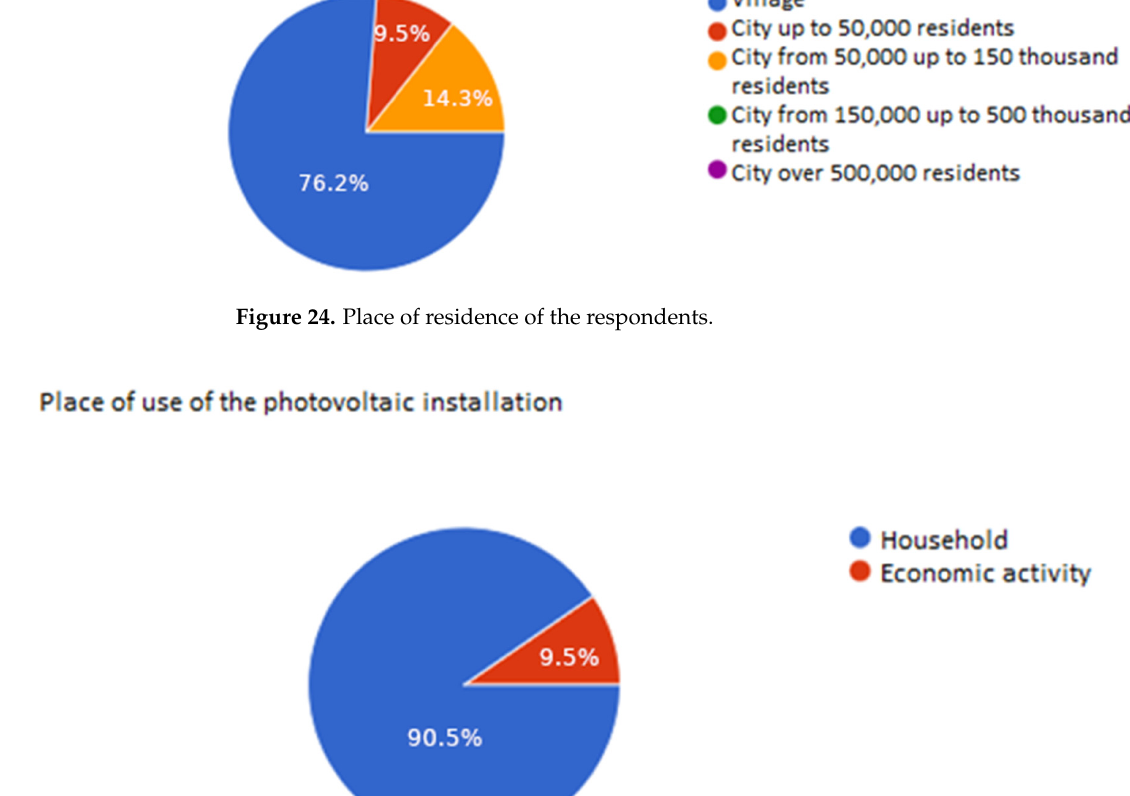
Figure 25. Place of use of the photovoltaic installation.